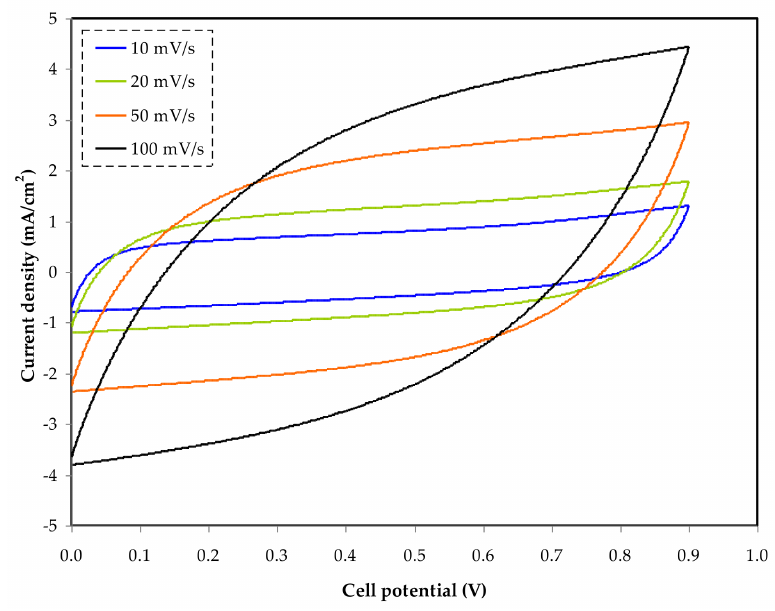
Figure 7. Cyclic voltammetry (CV) at various scan rates of 10, 20, 50, and 100 mV s − 1 . Table 5. Specific capacitance (F g − 1 ) value at various scan